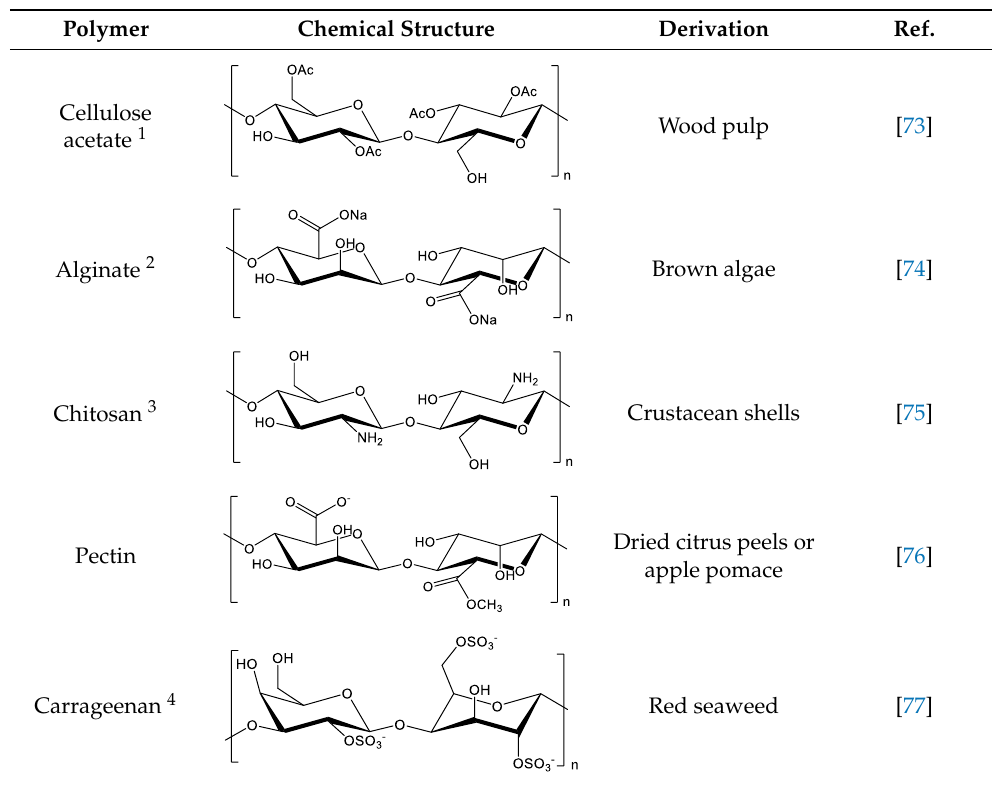
Table 2. Natural and renewable common polymers/gels employed for the development for water filtration membranes.